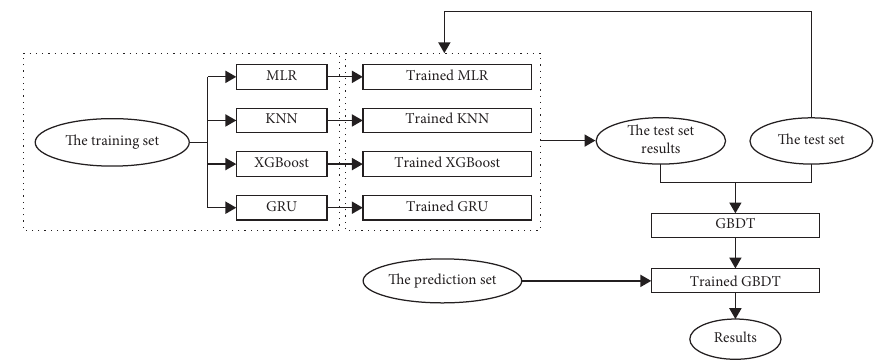
Figure 7: Ensemble flowchart based on the regression model.